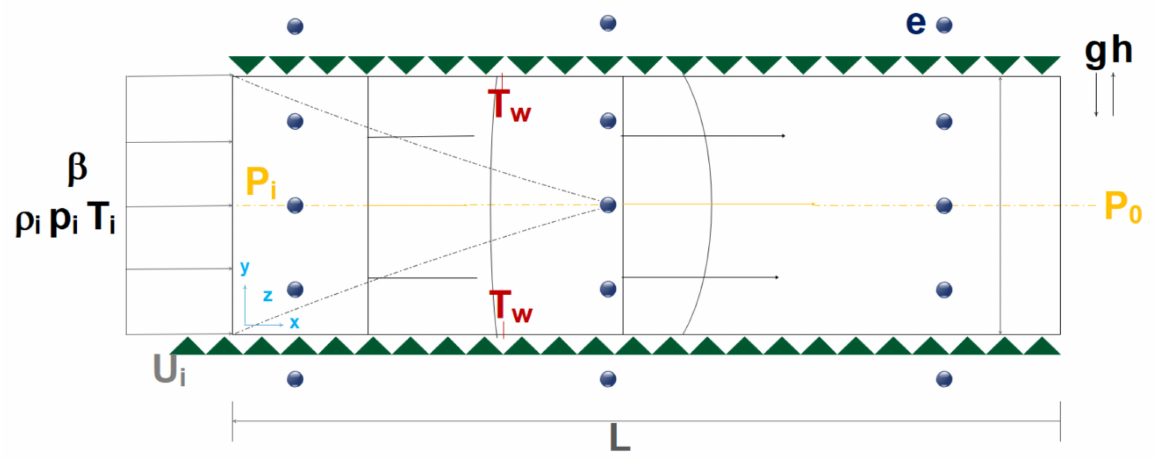
Figure 15. Model of analysis. e = (0, 0,e 0 ) and h = (0,h 0 , 0)